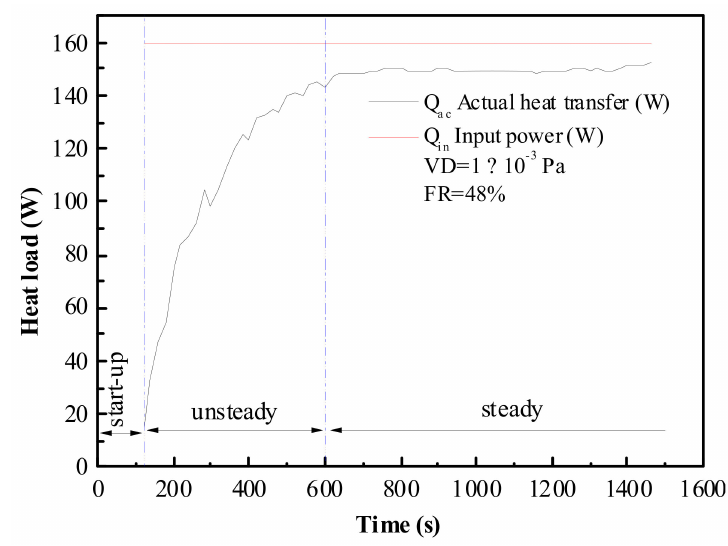
Figure 15. The heat load variation with heating time of the PGHP at 160